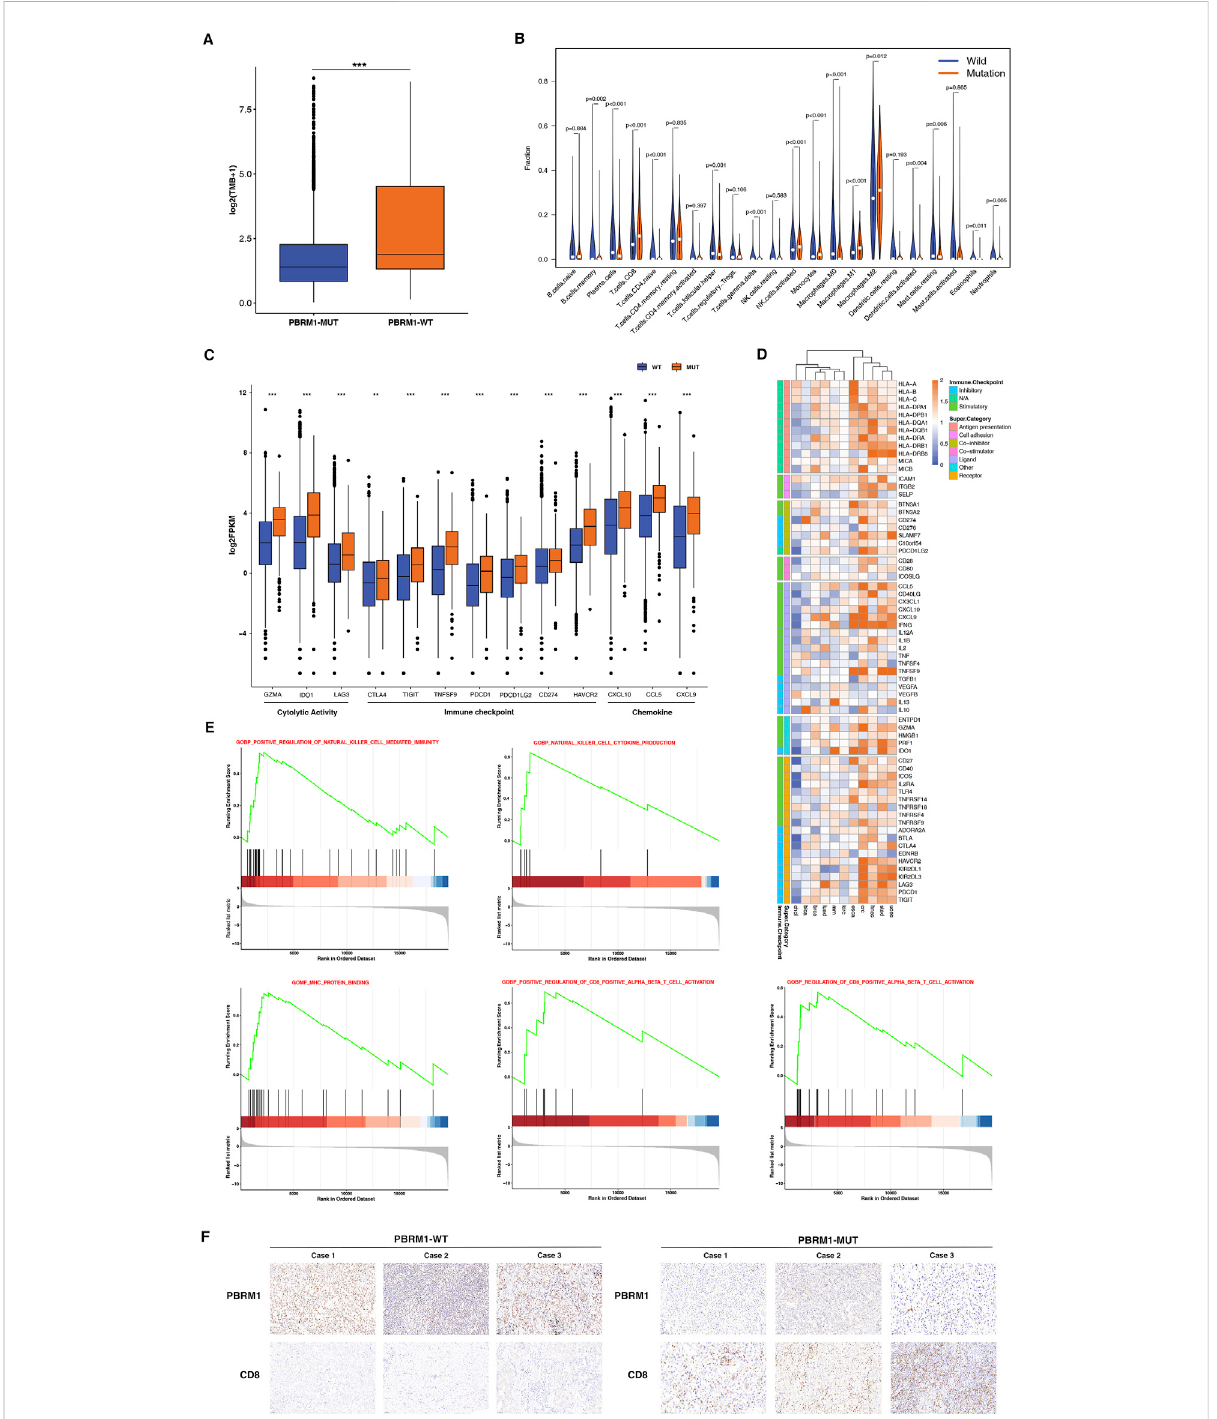
FIGURE 6 PBRM1-MUT was associated with enhanced anti-tumor immunity in TCGA cohort. (A) Comparison of the TMB between PBRM1-WT and PBRM1-MUTtumorsinTCGAcohort. (B) Comparison oftheimmunecellsin fi ltrationlevelsinPBRM1-MUTandPBRM1-WTtumors.CIBERSORT was used to calculate the in fi ltration degree of these immune cells. (C) Boxplot depicting the expression level of immune-related genes in PBRM1-MUT and PBRM1-WT groups. (D) Heatmap shows change in the expression level of immune-related genes across multiple cancer types in PBRM1- MUT and PBRM1-WT. Blue indicated downregulation and orange indicated upregulation. (E) GSEA plot was used to analyse representative immune pathways identi fi ed by GSEA between PBRM1-MUTand PBRM1-WT tumors. (F) Quantitative immunohistochemistry (IHC) analysis of PBRM1 and CD8 protein expression in the PBRM1-MUT and PBRM1-WT groups ( n = 3/group). ** p < .01, *** p < .001, **** p <